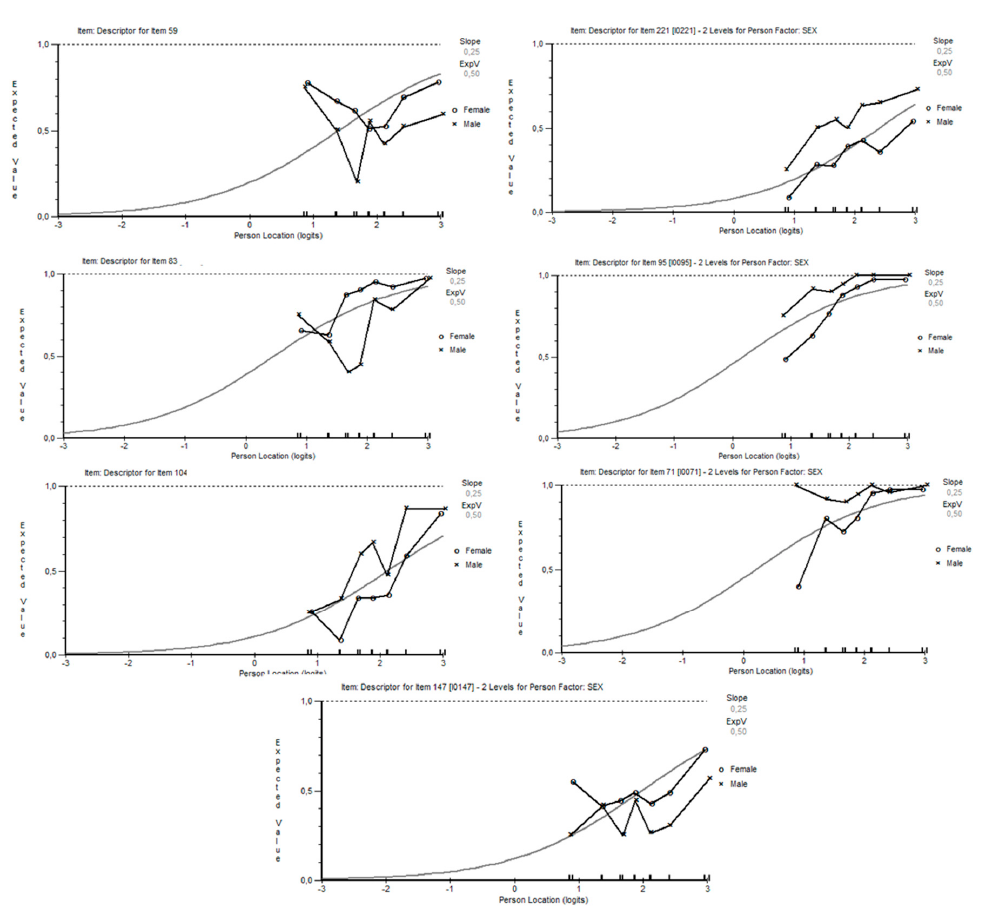
Figure 4. Item characteristic curves of DIF items (from left to right: items 59, 221, 83, 95, 104, 71, 147).